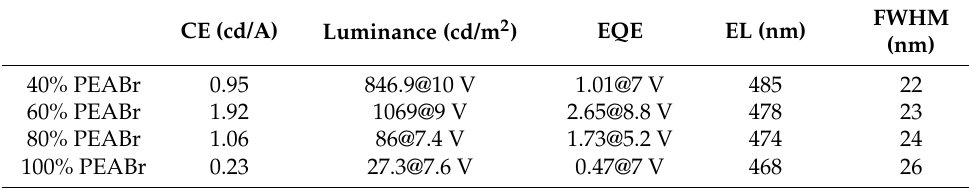
Table 2. Summary of CsPbCl 0.75 Br 2.25 PeLEDs with different ratios of PEABr.